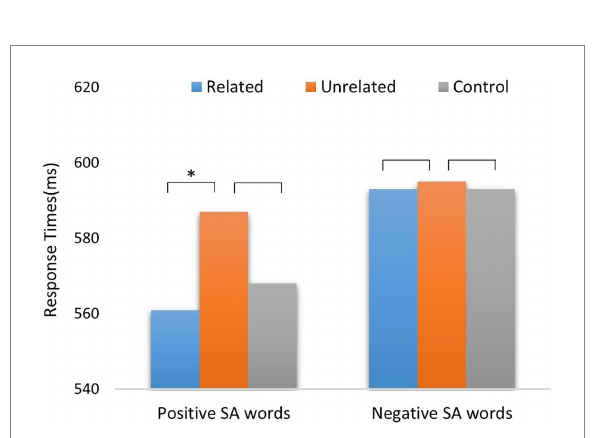
FIGURE 4 Response times of positive/negative SA words in social-semantic related, unrelated, and control conditions. SA words = Social Abstract